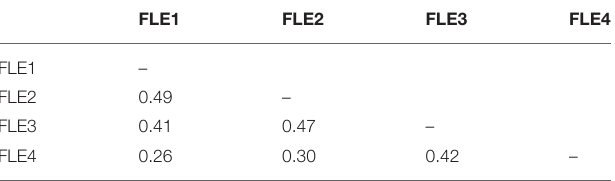
TABLE 1 | Correlation matrix between FLEs over time.